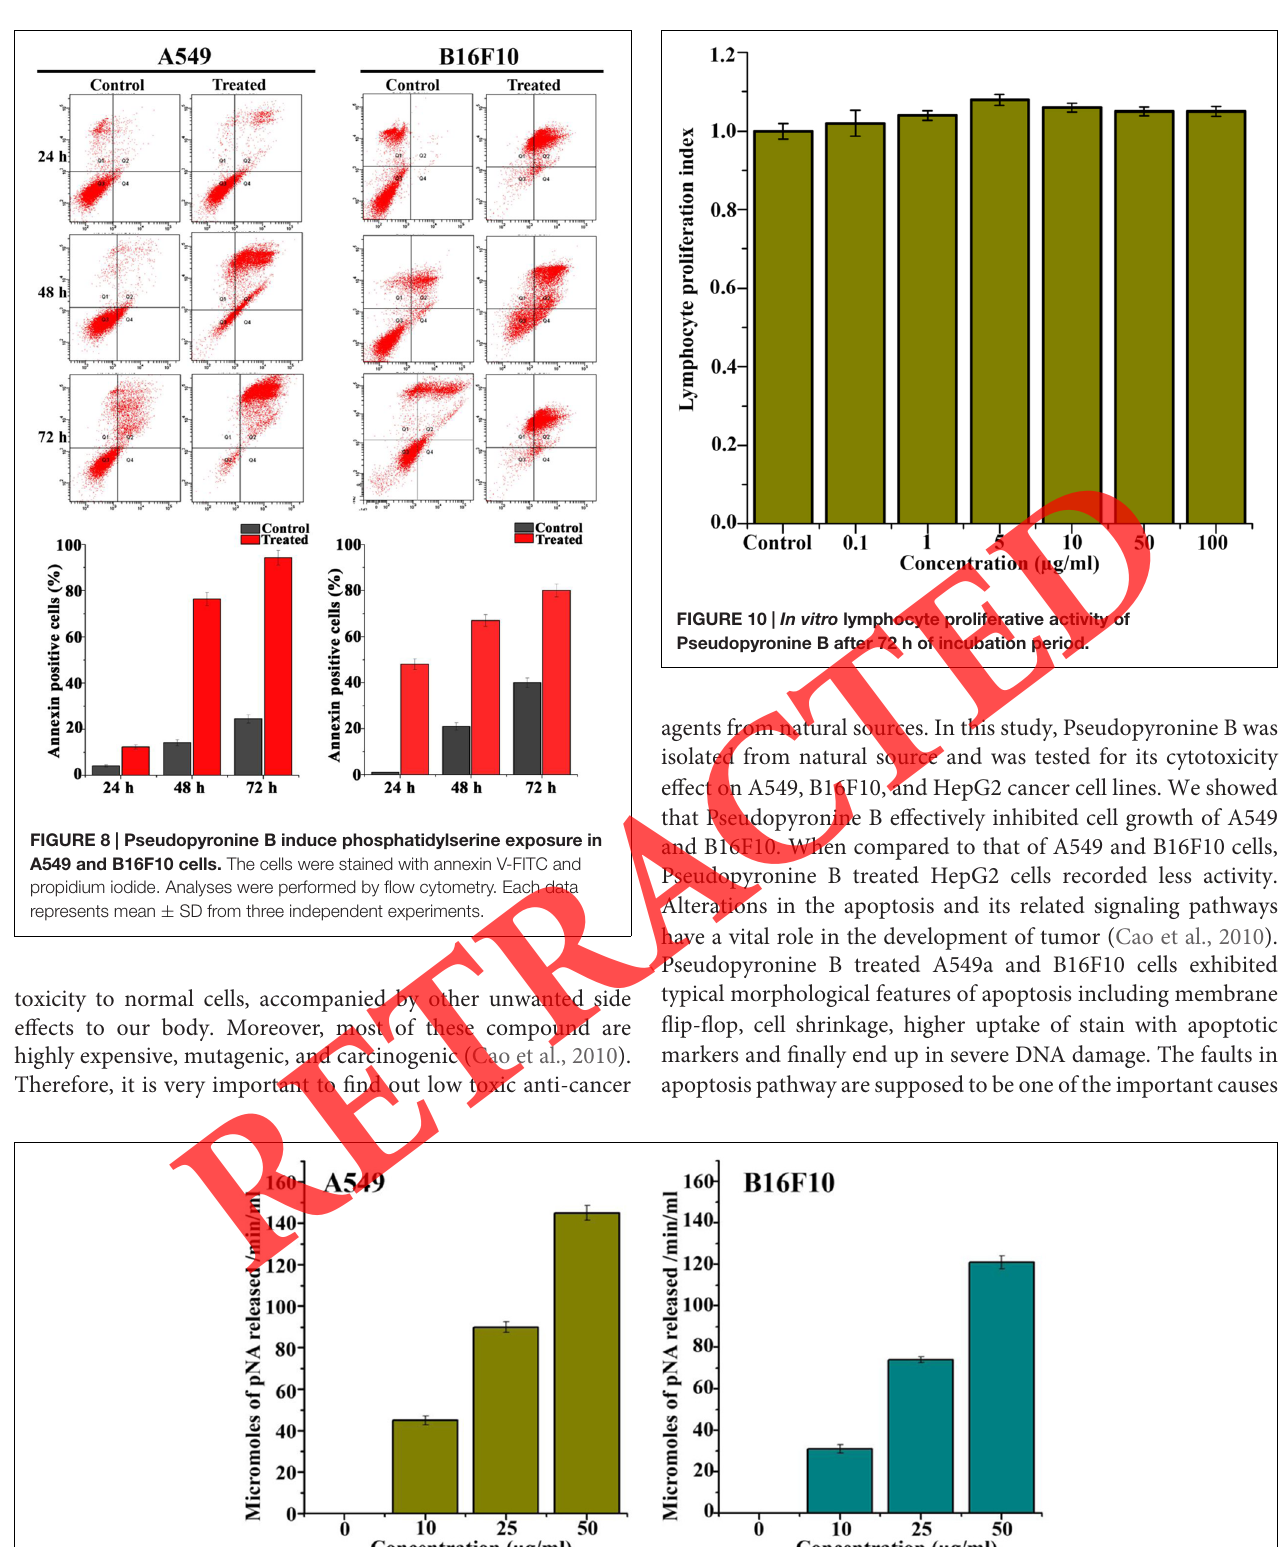
FIGURE 9 | Effect of Pseudopyronine B on the release of caspase 3 in A549 and B16F10 cells. The experiments where performed in three replication and results were expressed as mean ± standard deviation.